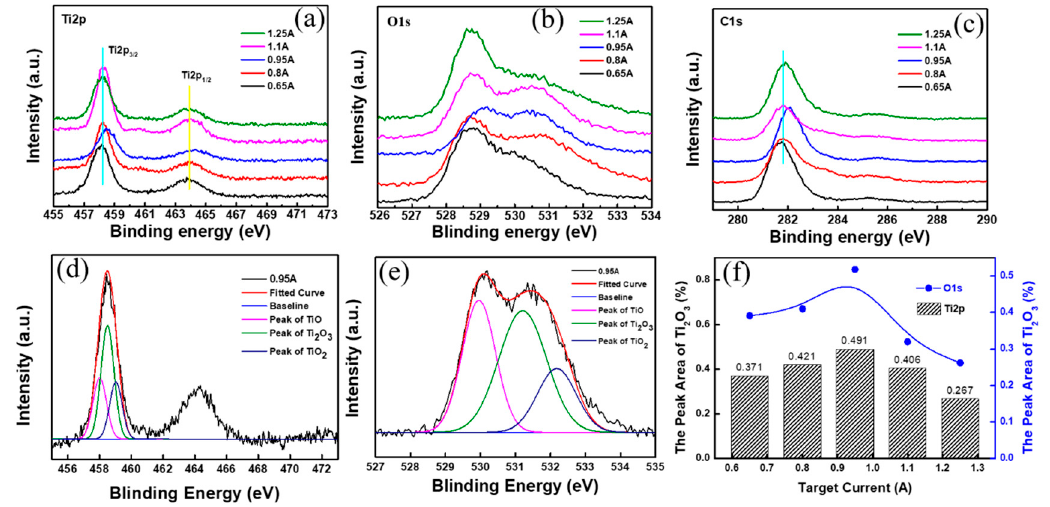
Figure 5. The X-ray photoelectron spectroscopy (XPS) spectra of ( a ) T2p, ( b ) O1s and ( c ) C1s for TiC x O y films deposited at different target current and the fitted results by a non-linear least squares procedure for TiC x O y films corresponding to ( d ) T2p, ( e ) O1s; ( f ) Ti 2 O 3 / ( TiO + Ti 2 O 3 + TiO 2 ) ratio of TiC x O y films deposited at different target current.